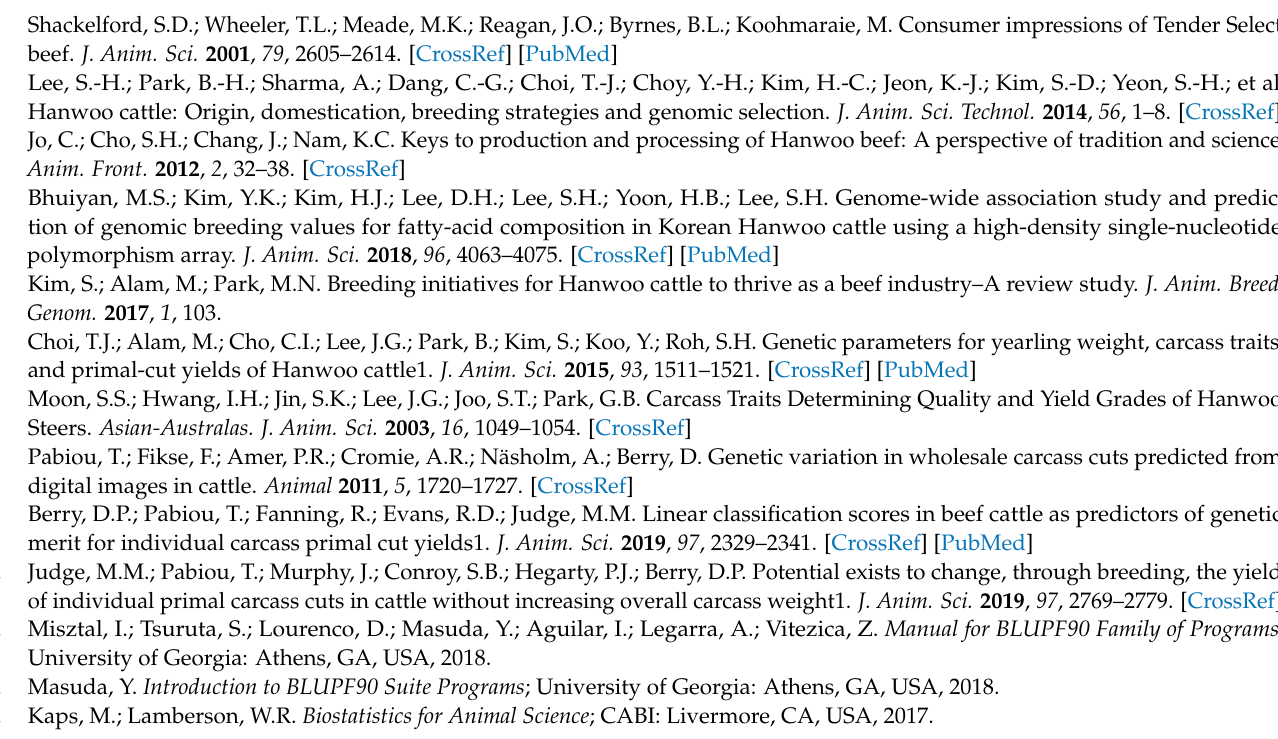
Table S1: The average of estimates of heritability (h 2 ), additive genetic variance ( σ 2 g ), residual variance ( σ 2 e ), and phenotypic variance ( σ 2 p ) for carcass traits, primal cut yields, and compos- ite traits using bivariate models in Hanwoo cattle; Supplementary Material File S1: Estimates of -2loglikelihoods for investigating significantly different from zero of genetic and phenotypic correla- tions; Supplementary Material File S2: The genetic parameters obtained using bivariate